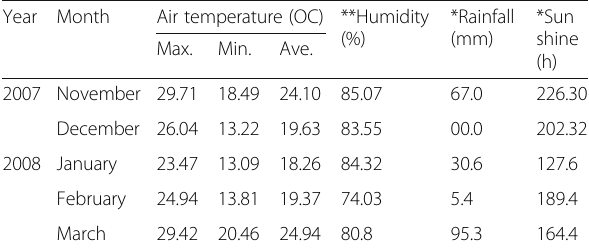
Table 5 Monthly average air temperature, relative humidity and sunshine during experimentation from November, 2007 to March,